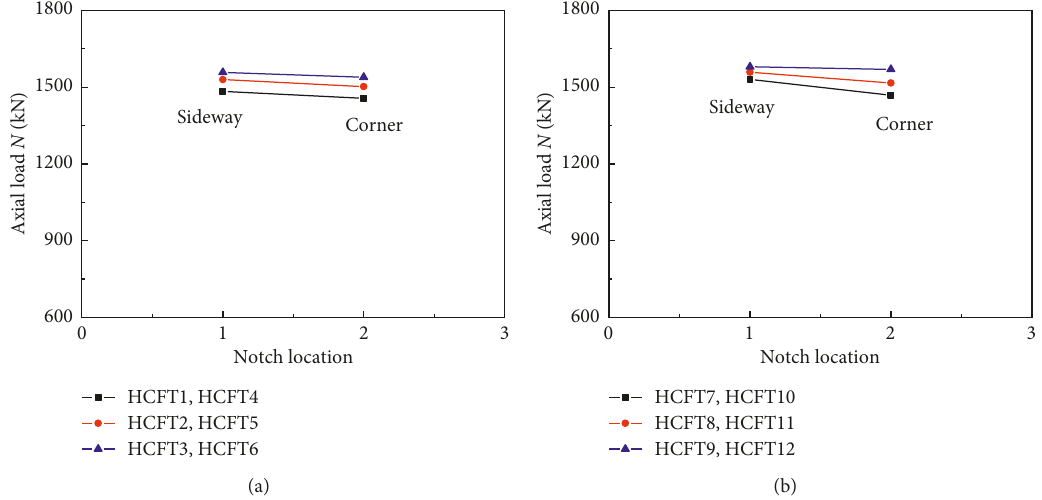
Figure 8: Influence of notch location on the ultimate strength of specimens. (a) Horizontal notch (HCFT1 ∼ HCFT6). (b) Vertical notch (HCFT7 ∼